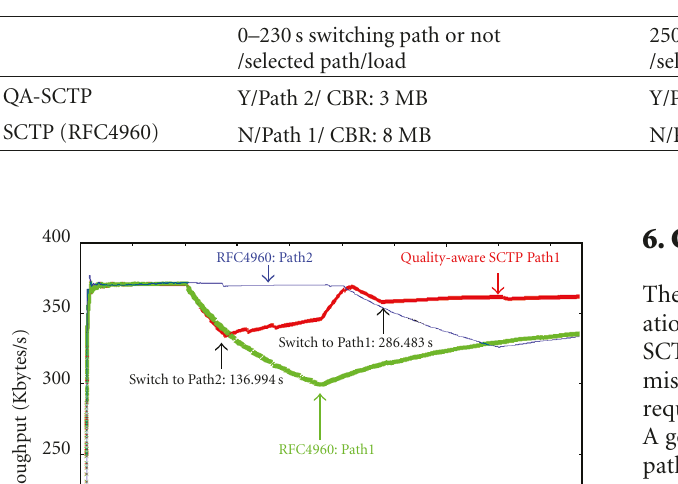
Table 5: Experiment results for QA-SCTP path condition measure/switching.